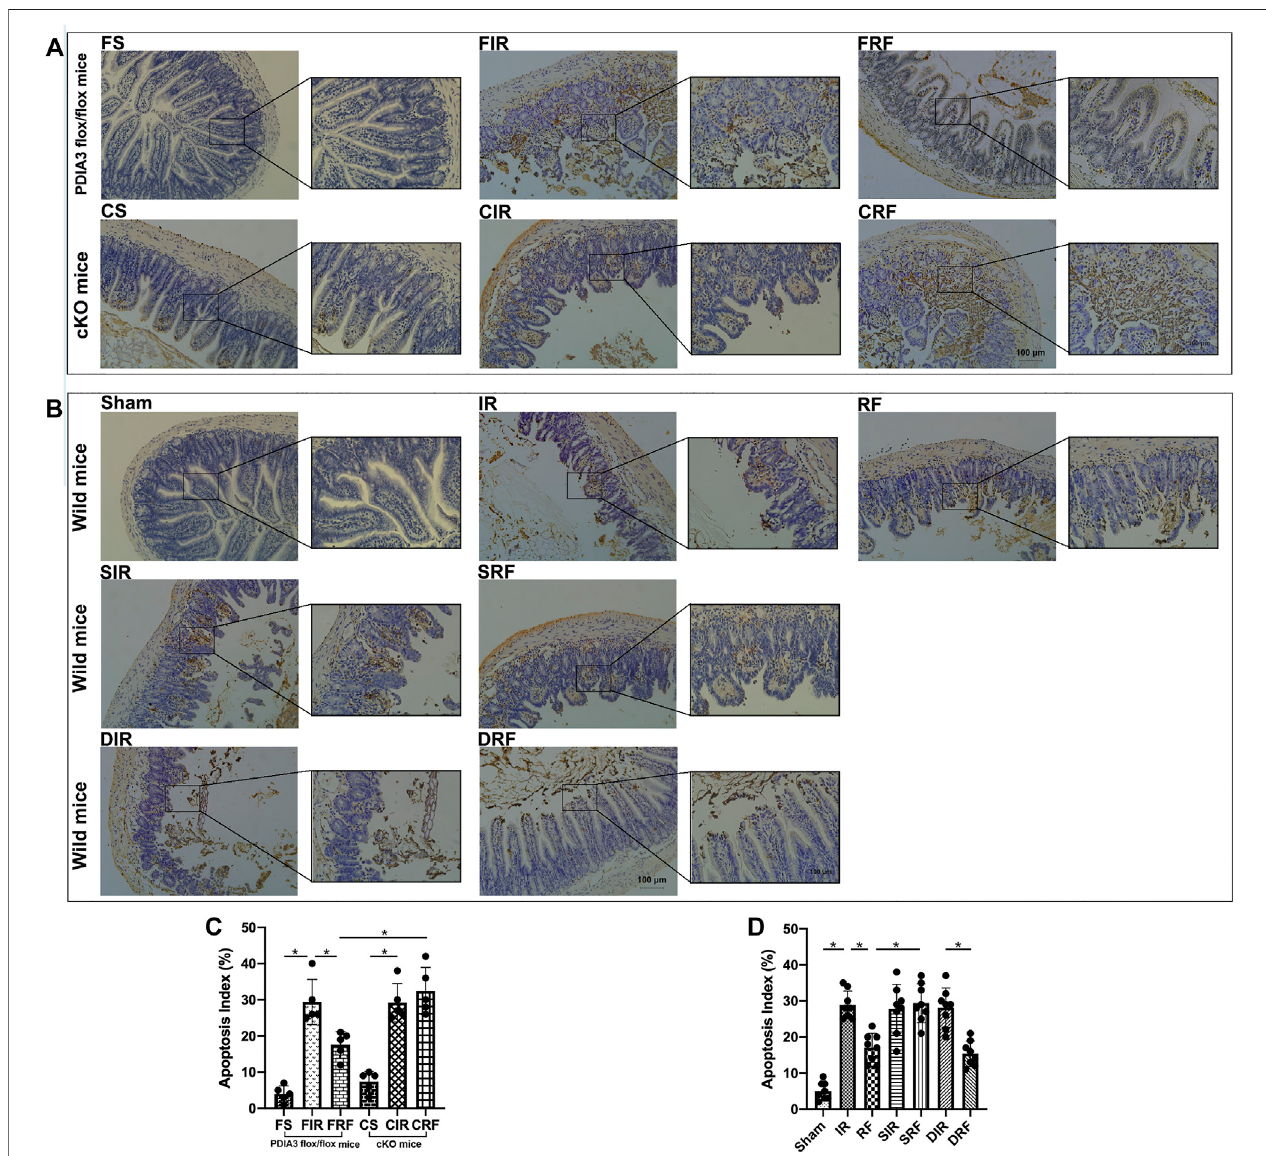
FIGURE 3 | TUNEL assay of the intestinal mucosal cell apoptosis by light microscopy (×200 and ×400, scale bar: 100 μ m). (A,B) The intestinal mucosal cell apoptosis changes assessed by TUNEL staining among the groups. Groups are the same as in Figure 1 . Apoptotic nuclei are stained dark brown. In the FS, CS, and sham groups, few apoptotic epithelial cells are observed at the villous. In the FIR, CIR, CRF, IR, SIR, SRF, and DIR groups, notable destruction of the villi is evident, and apoptoticenterocytesarepresentintheupperregionsofthevilli.Inaddition,largenumbersofdetachedepithelialcellswithdarkbrownnucleiareseenintheenteric cavity. Inthe FRF, RF, and DRF groups, thedamage ofvilli is slight,and there arefewer apoptotic cellsthan in the FIRand IRgroups. (C,D) Apoptotic indicesamong the groups. Data are expressed as mean ± SD, n = 5 – 8. The results were compared by ANOVA with Tukey ’ s post hoc test. * P < .05.